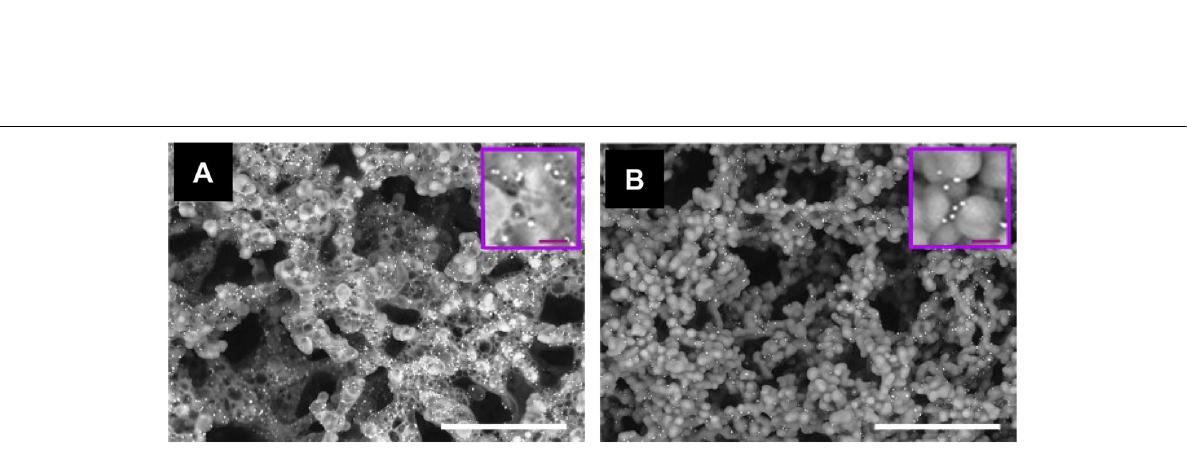
Fig. 9 Backscattered electron images of gold/platinum particle-labeled immunocomplexes on cellulose membrane. A Without the NanoSuit treatment. B With the NanoSuit treatment. Bars the